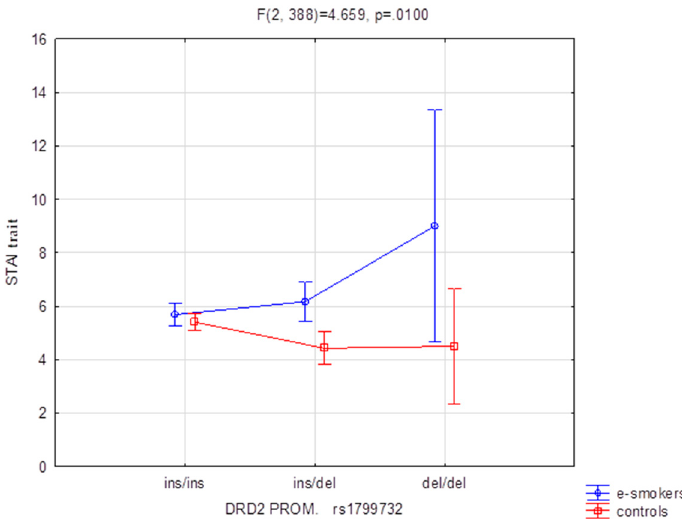
Figure 1. The group (e-cigarette users vs. controls) DRD2 rs1076560 polymorphism interaction for the NEO FFI Neuroticism.